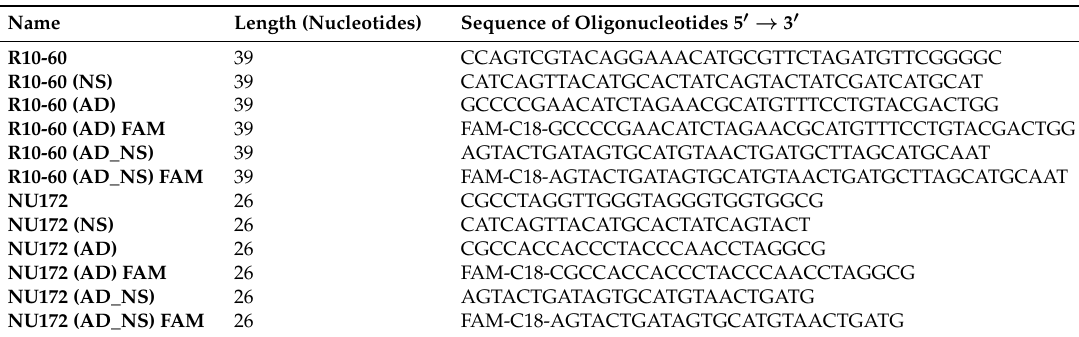
Table 1. List of used